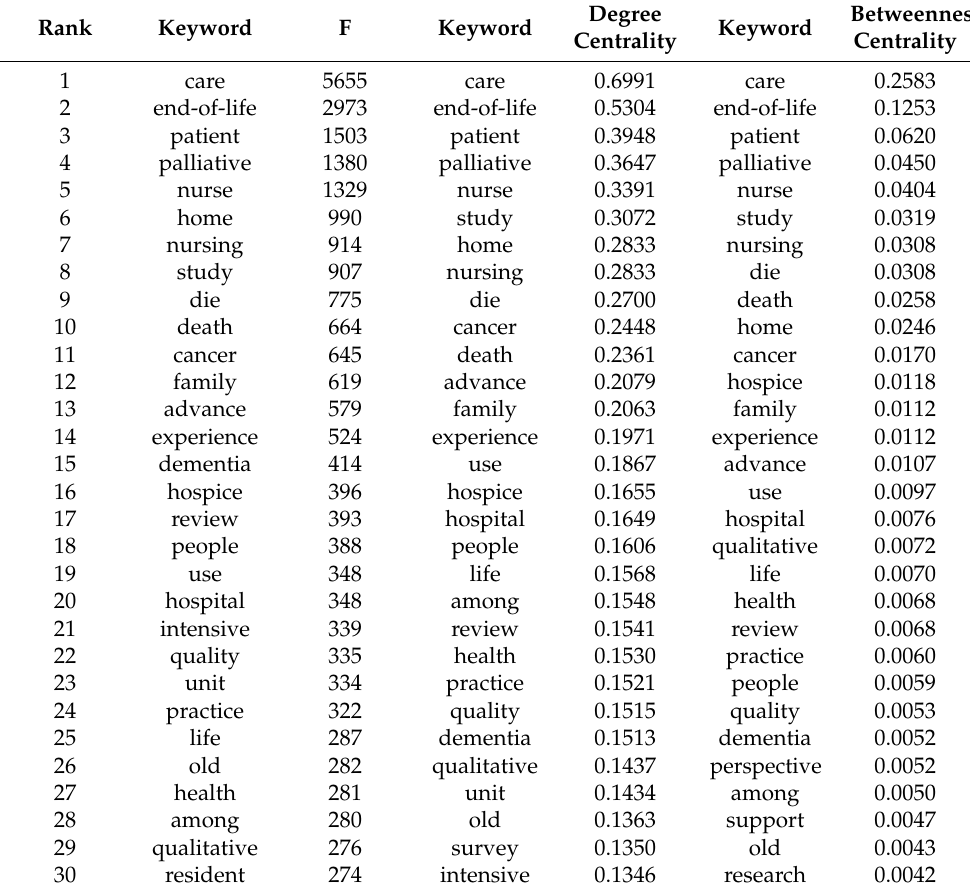
Table 2. Top 30 keywords that emerged from the end-of-life (EOL) care